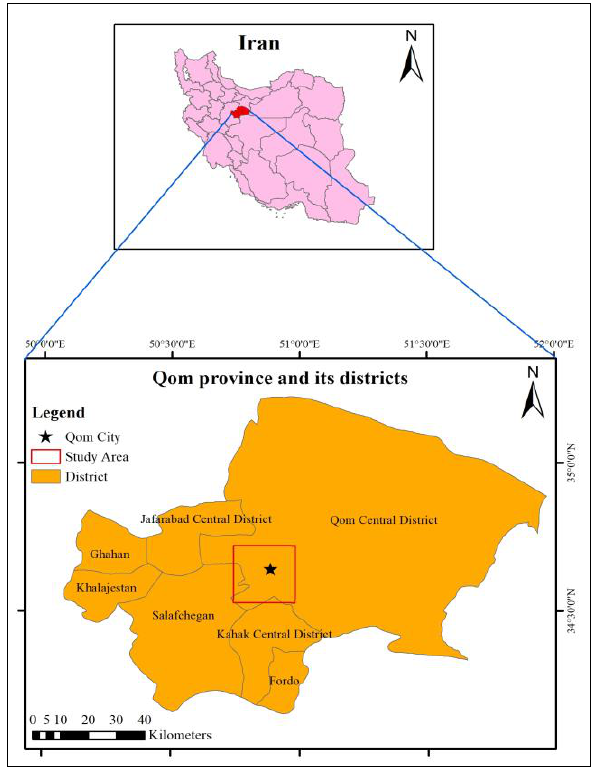
Figure 1 . Map of the study